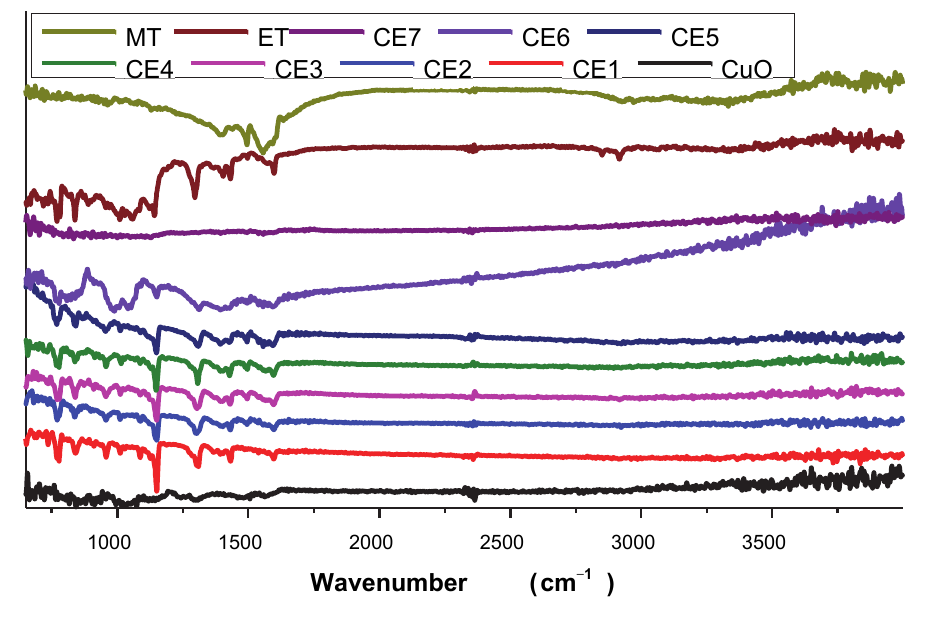
Molecules 2022 , 27 , x FOR PEER REVIEW